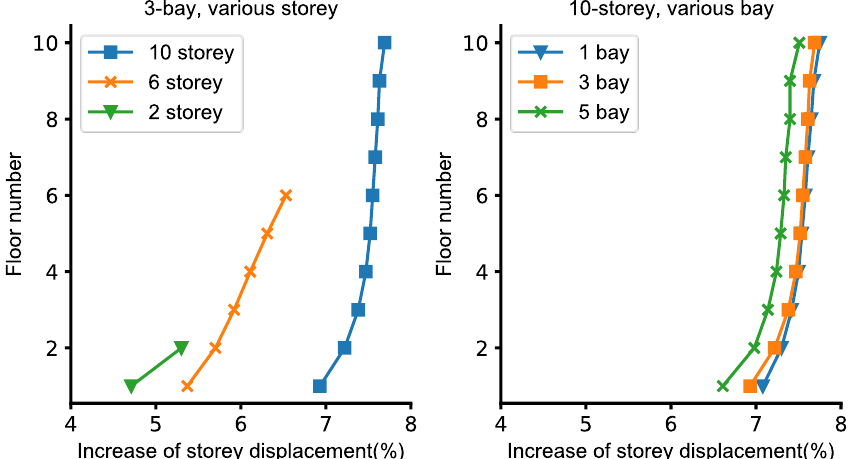
Figure 10. Increase of inter-story lateral displacement caused by negative deviation of fixity-factor for the three-span ten-story frame.